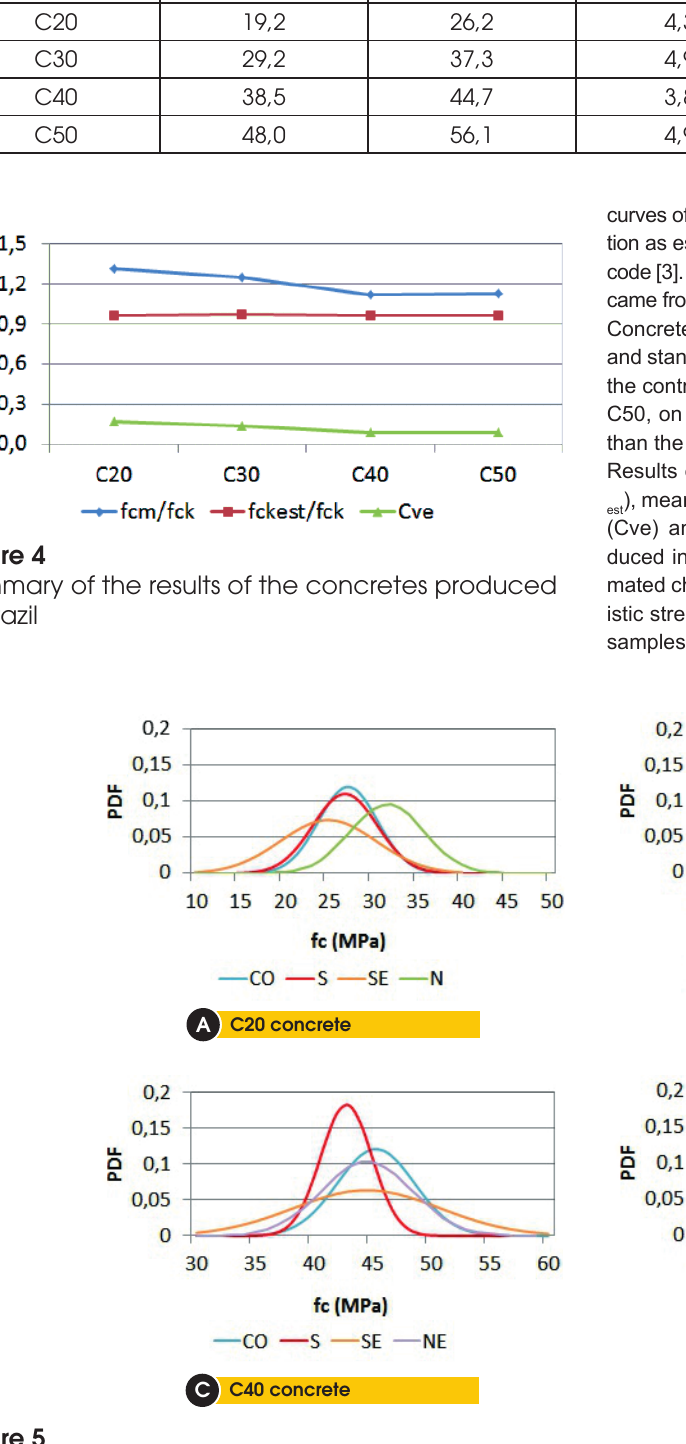
Comparison between the distribution functions of concrete produced in the different regions of the